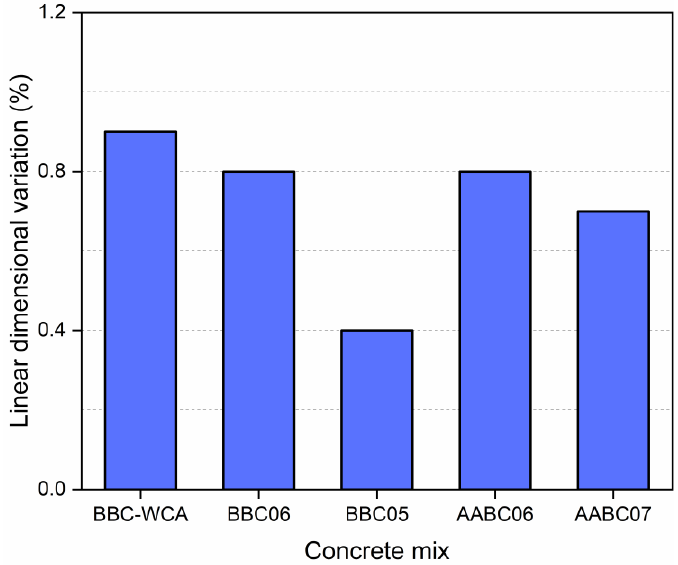
Figure 14. Linear dimensional variation for paver blocks produced with each concrete mix.